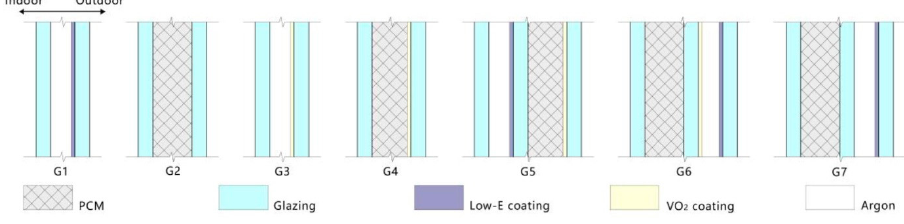
Figure 29. Different DG and TG systems used by Jin et al. [96].